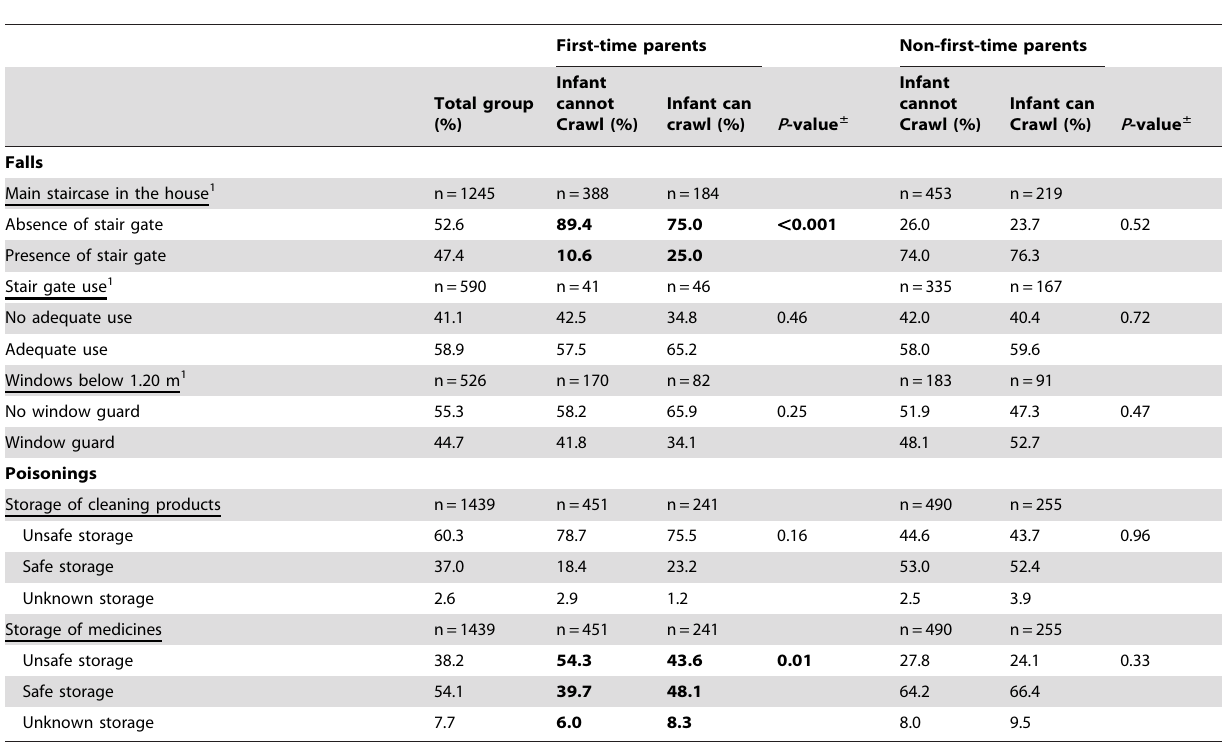
Table 2. First-time and non-first-time parents’ safety behaviour relevant to the prevention of falls and poisonings, compared between infants who cannot crawl and infants who can crawl